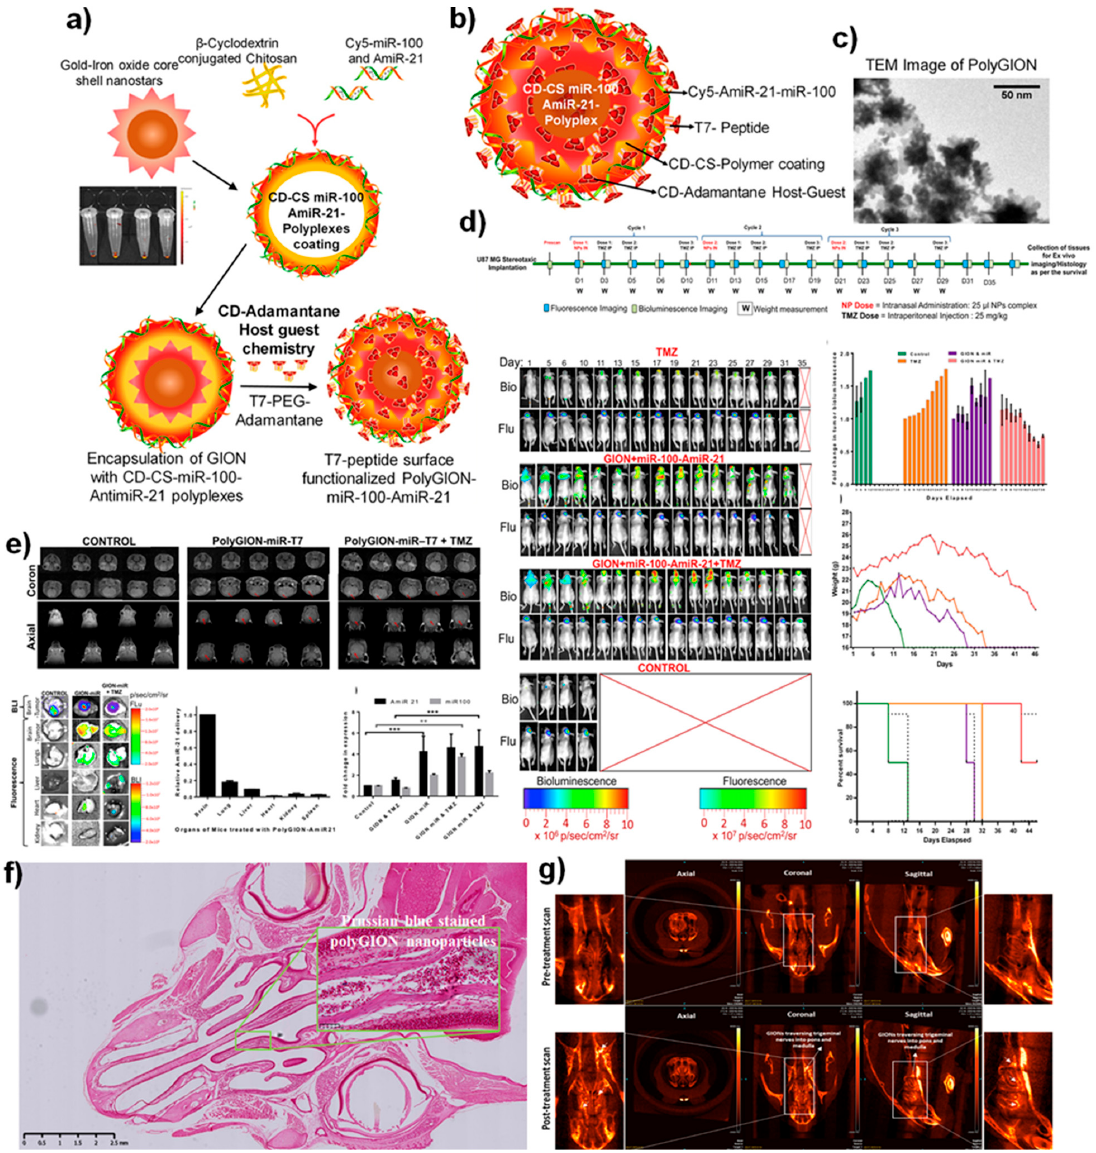
Figure 3. ( a ) Schematic illustration of the synthesis of Poly-gold-iron oxide nanoparticles (polyGIONs) system and in vitro fluorescence images of Cy5 labeled miR-100 and antimiR-21 loaded cyclodextrin-chitosan (CD-CS) hybrid polymer complexes. ( b ) Schematic of the as-prepared polyGION nanoparticle structure and the associated compositions. ( c ) TEM micrograph of GIONs. ( d ) In vivo treatment flow chart of the therapeutic design and imaging timelines; fluorescence (Cy5-miRNA loaded nanoparticles) and bioluminescence (FLuc-EGFP expressing glioblastoma model); quantitative measurements for the tumor bioluminescence measured concerning treatment duration; mice body weight profiles over the treatment duration and their survival curve indicates the intranasally delivered nanoparticles towards the theranostic efficacy. ( e ) 3T MRI scanning (coronal and axial) of the polyGIONs-miRNAs treated mice brain imaging; biodistribution; ex vivo fluorescence imaging, and qRT-PCR of antimiR-21 and miR-100 expression levels. Reprinted (adapted) with permission from Reference [51]. ( f ) H&E-stained histological image shows the nasal epithelium, followed by iron-specific Prussian blue staining (inset figure) to trace the accumulation of polyGION nanoparticles in mice intranasal cavities. ( g ) microCT imaging of mice head scan shows the non-treated (control) and T7-polyGION-CD-CS NPs administered in vivo. Corresponding microCT scan images depict the migration of IN administered T7-polyGION-CD-CS NPs nanoparticles movements through the olfactory nerve pathway into the olfactory bulb and passing into trigeminal